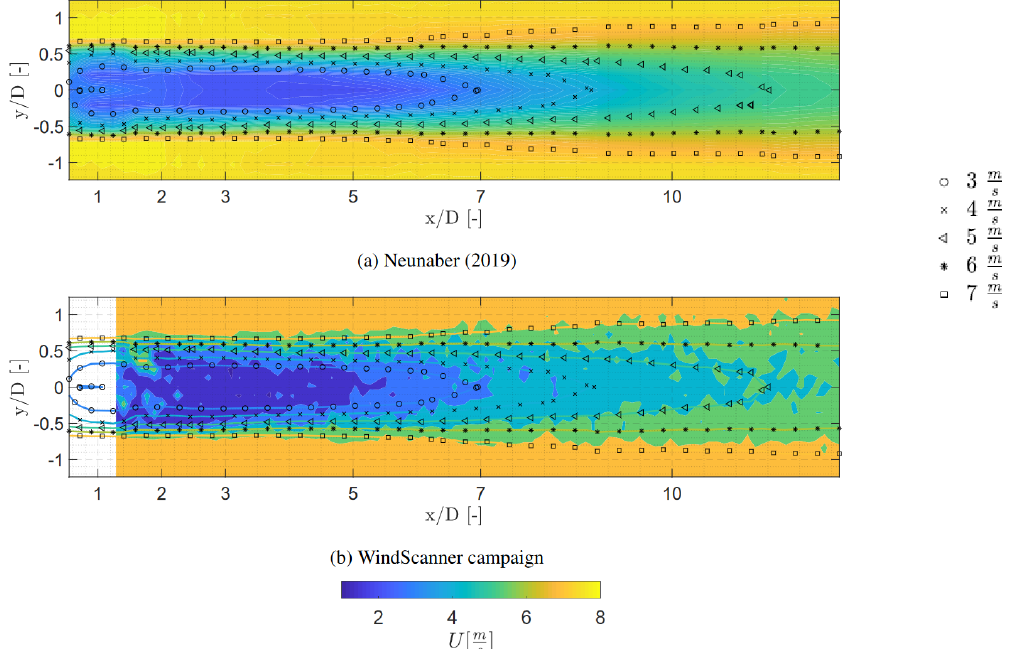
Figure 12. Comparison of the profiles of the averaged streamwise velocity component at 1, 2, 3, and 5 D between the WindScanner mea- surements and the hot-wire measurements at Neunaber (2019). Both measurements were conducted with no grid at U = 7 . 5ms − 1 . Lines with a marker indicate the contours at U = [ 3 , 4 , 5 , 6 , 7 ] ms − 1